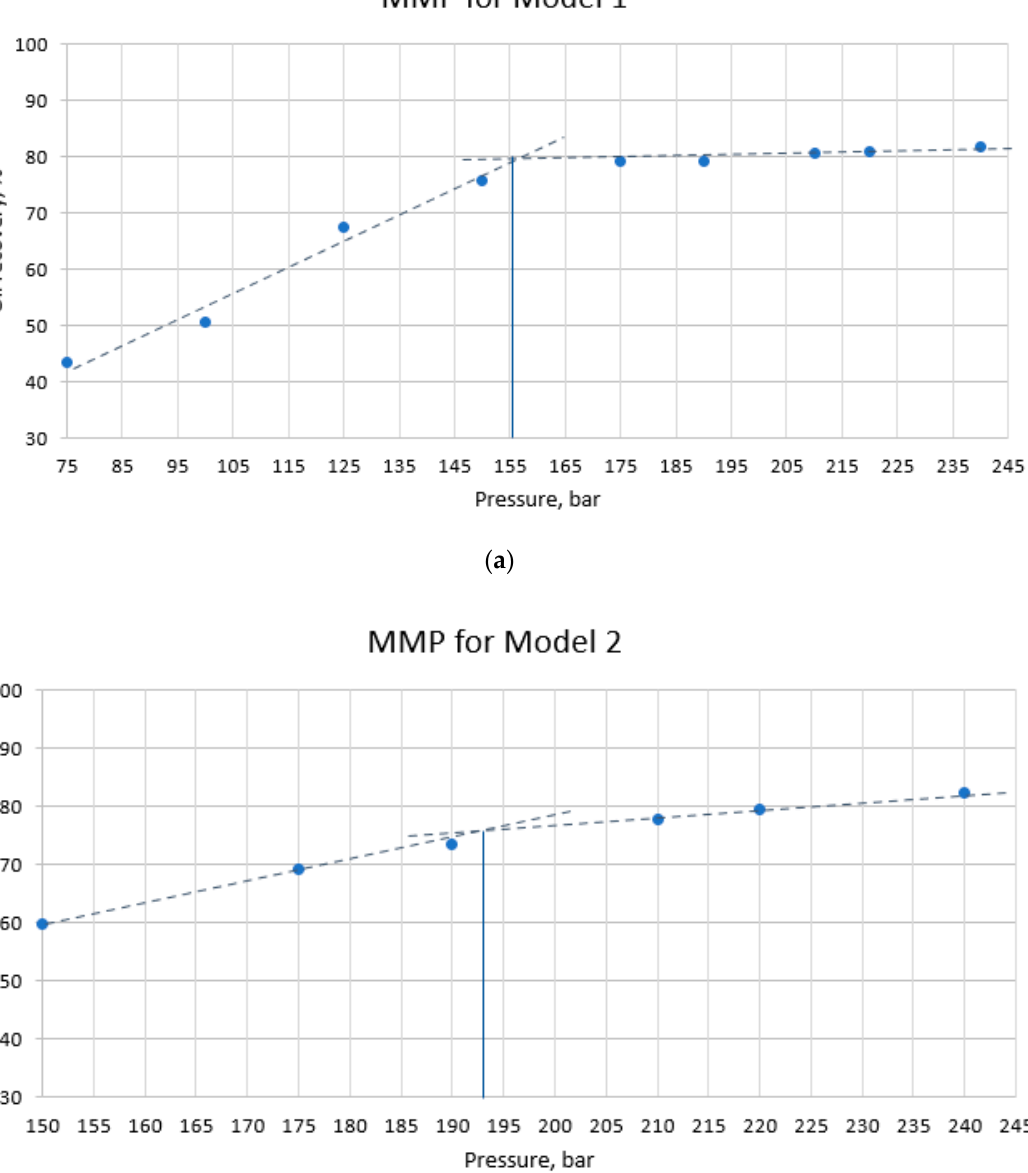
Figure 3. Minimum miscibility pressure for ( a ) Model 1 and ( b ) Model 2